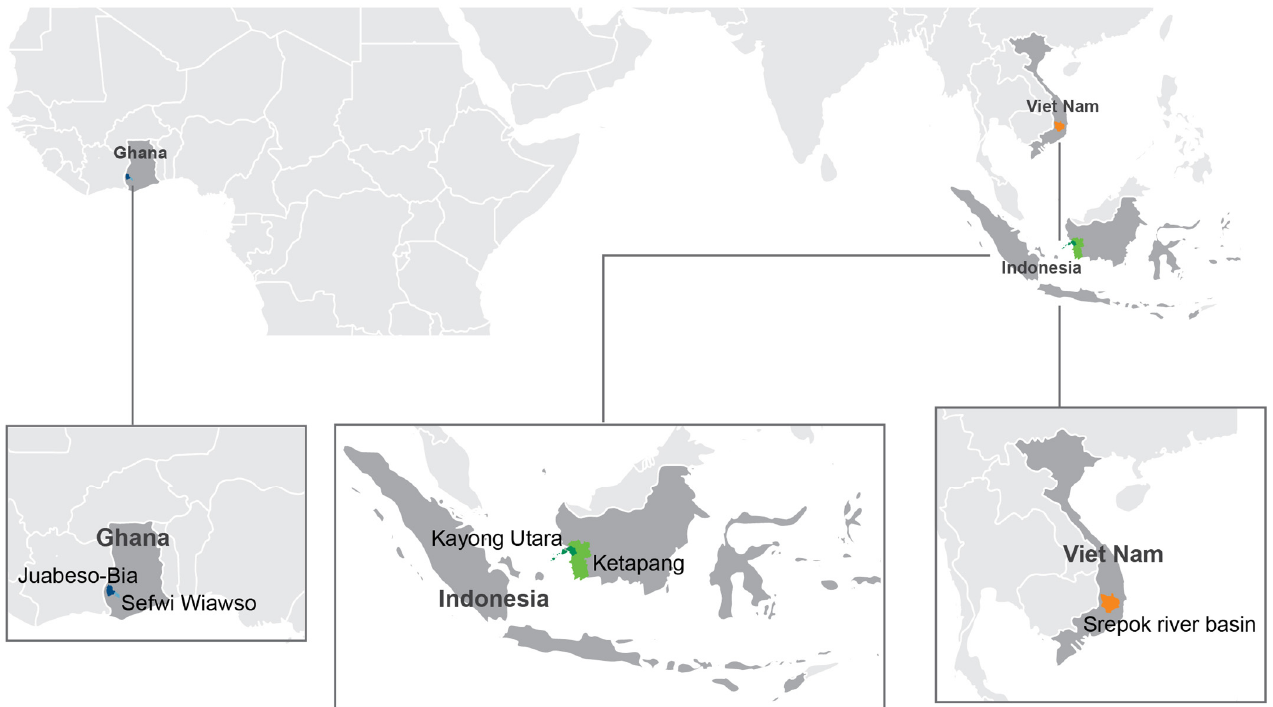
Figure 2. The location of the research areas (elaboration by Juanita Franco, Tropenbos International).